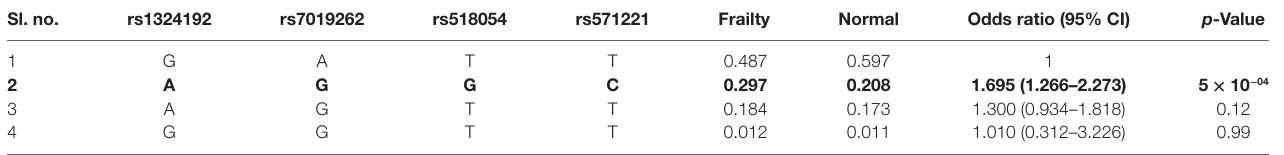
Significant difference in the haplotype (2) involving the risk alleles of associated SNPs was observed with 29.7% in individuals with frailty compared with 20.8% in normal. Haplotype analysis was adjusted for age and gender.